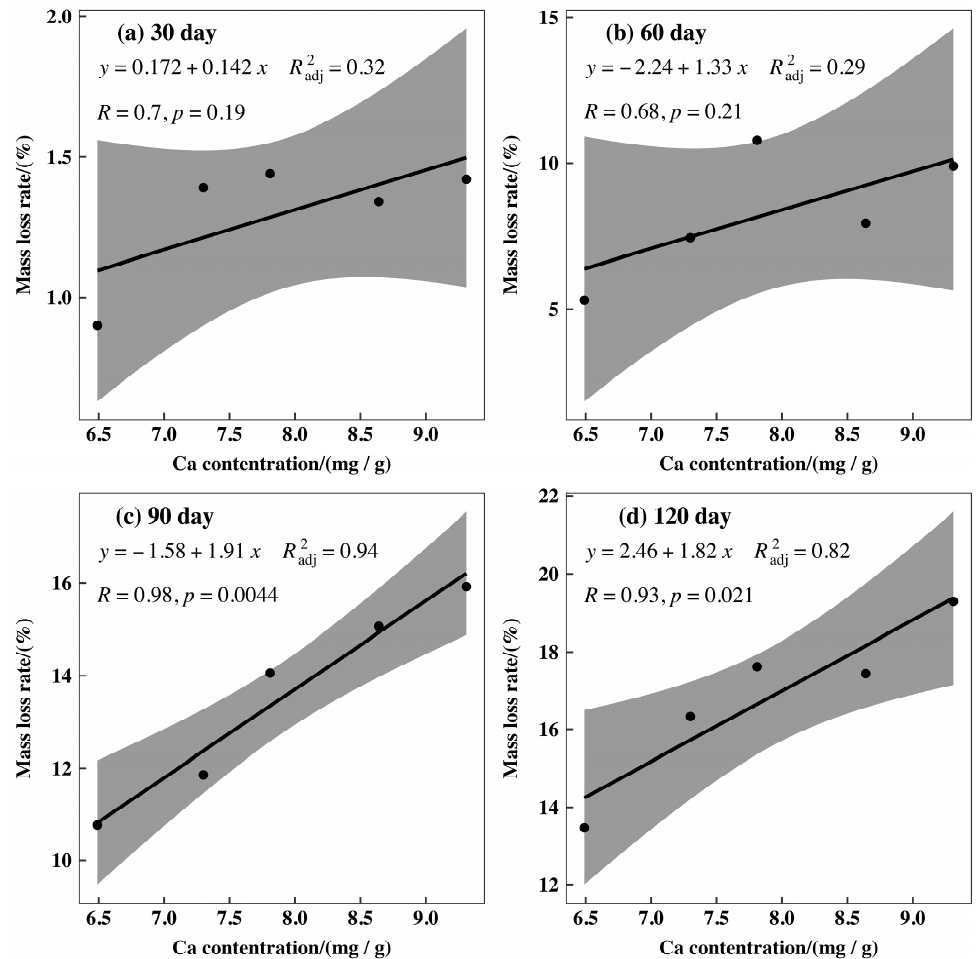
Figure 10. Linear relationships between initial litter Ca concentration and accumulated mass loss for each sampling day. ( a ) The linear relationship between initial litter Ca concentration and accumulated mass loss in 30 days. ( b ) The linear relationship between initial litter Ca concentration and accu- mulated mass loss in 60 days. ( c ) The linear relationship between initial litter Ca concentration and accumulated mass loss in 90 days. ( d ) The linear relationship between initial litter Ca concentration and accumulated mass loss in 120